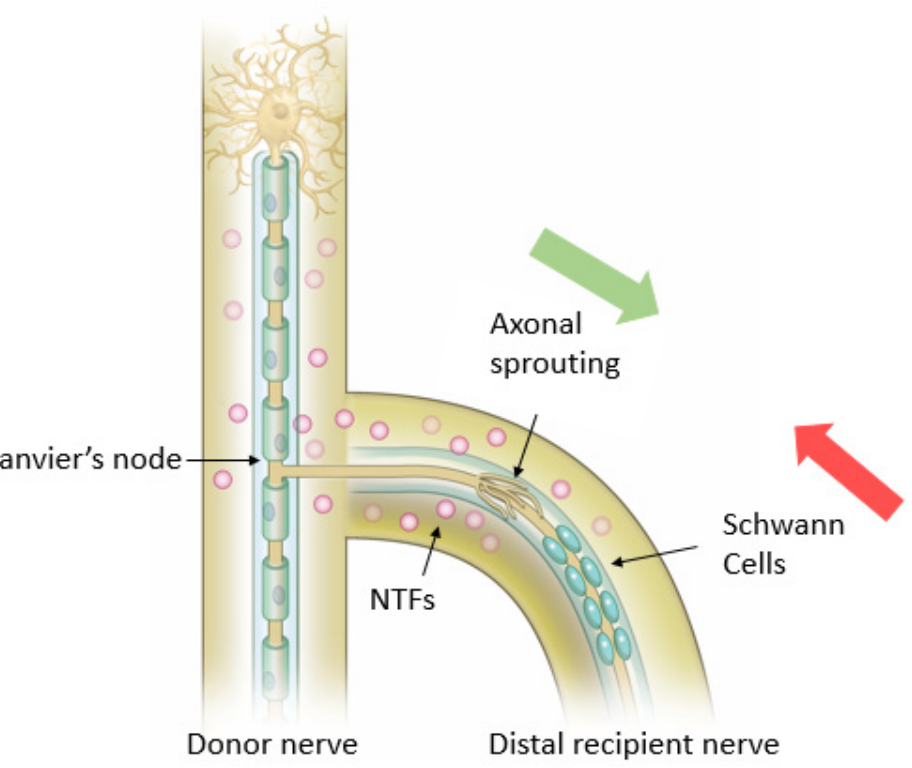
Figure 6. Proposed mechanism for axonal regeneration in End-To-Side (ETS) repair. Schwann cells from donor nerve and/or recipient nerve de-differentiate into the reparative phenotype and align themselves at the coaptation site. Collateral axonal sprouting occurs at the node of Ranvier closest to the coaptation site. NTFs = Neurotropic Factors